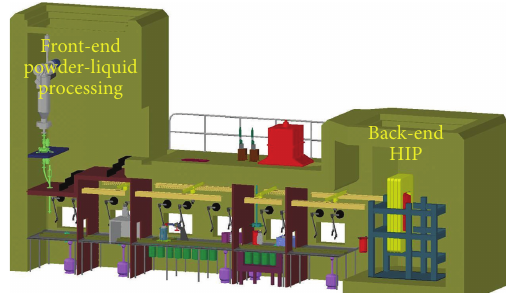
Figure 6: Initial conceptual plant design for the treatment of ILLW wastes at